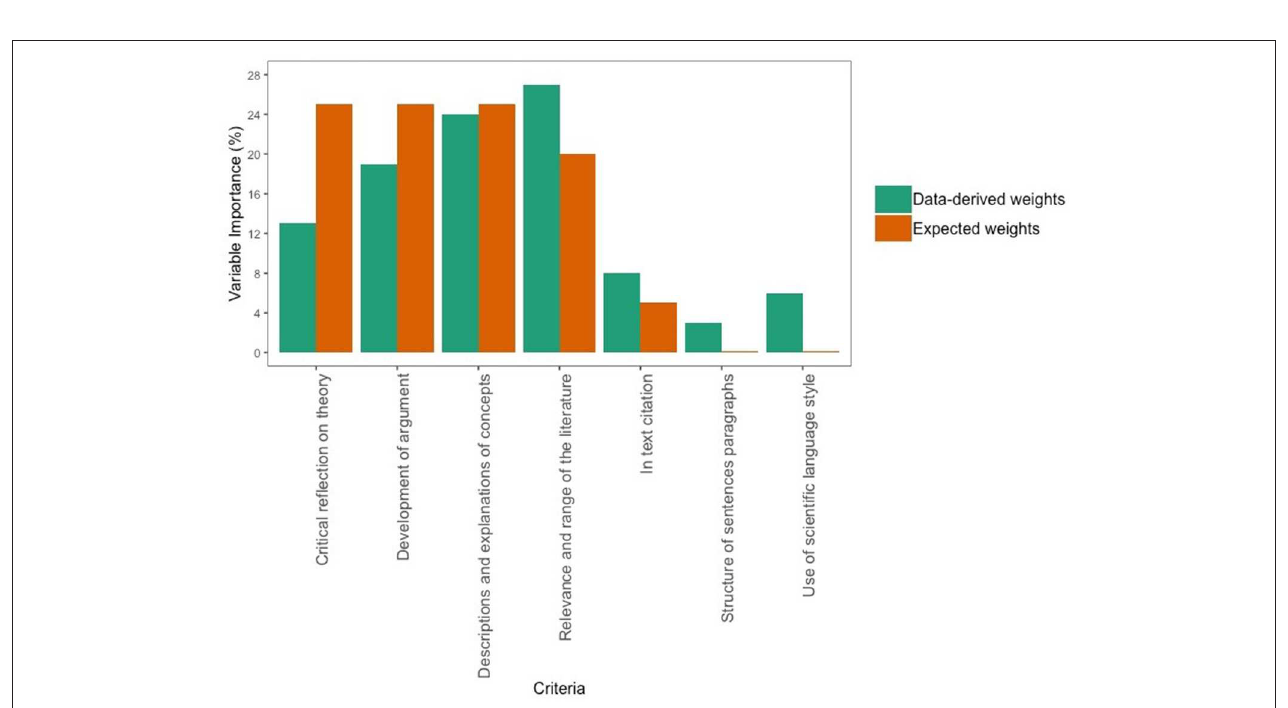
FIGURE 6 | Year 2 Essay questions (exams): data-derived and expected weightings.